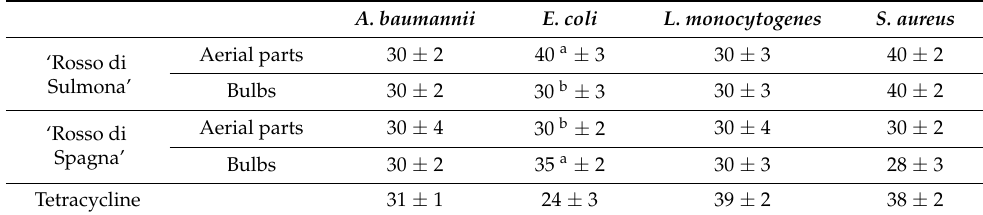
Table 5. Minimal inhibitory concentration ( µ L/mL) of the EOs from two cultivars of A. sativum necessary to inhibit the growth of the pathogenic bacterial strains Listeria monocytogenes , Escherichia coli , Acinetobacter baumannii , and Staphylococcus aureus